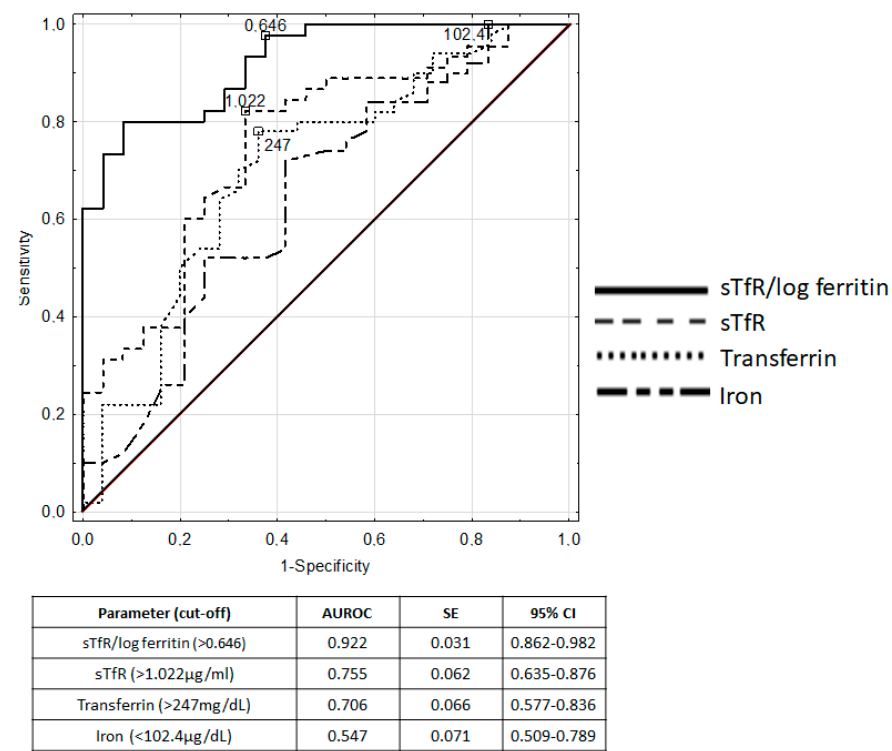
Figure 2. ROC curves and area under ROC for biochemical markers of iron deficiency recognition in IBD children.